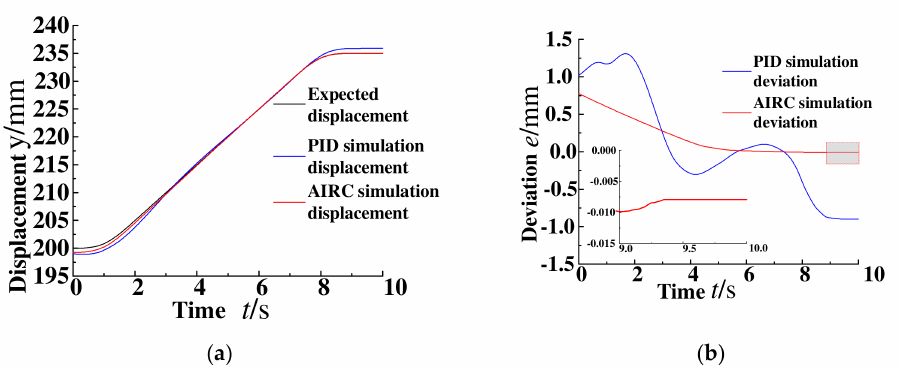
Figure 7. System displacement and deviation curve under working condition 2 (cid:13) . ( a ) System displace- ment curve. ( b ) System displacement deviation curve.